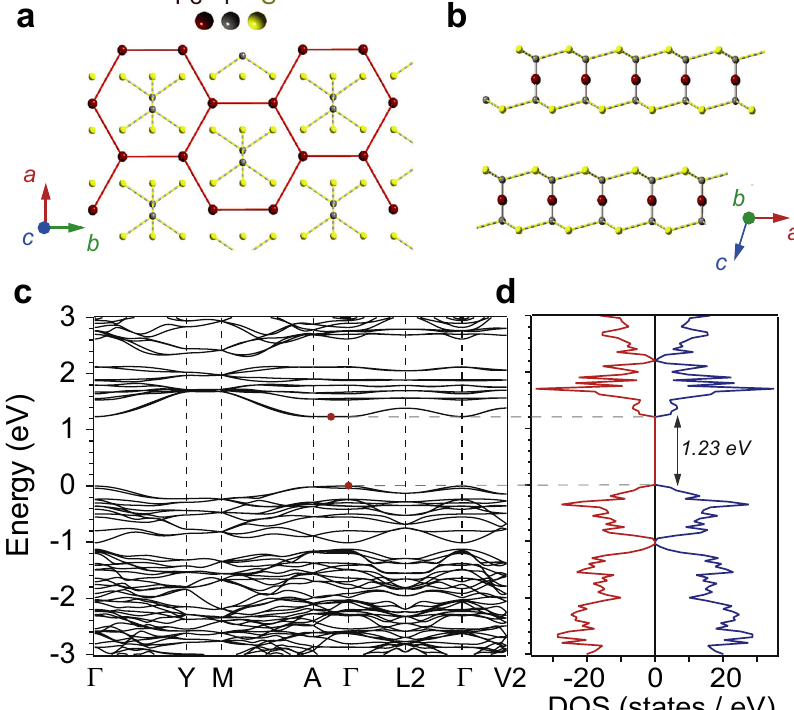
Fig. 3 Calculated band structure and DOS. a Top view and b side view of the crystal structure of FePS 3 . Fe 2 + ions form a honeycomb lattice, enclosed by the (P 2 S 6 ) 4 − bipyramids. The stacking of the layers of the monoclinic crystal structure is shown. Calculated GGA + D2 + U c band structure and d density of states: spin up (blue) and spin-down (red). The maximum and minimum of the valence and conduction bands respectively are marked with red dots de fi ning the indirect energy data in a Tauc plot representation. Assuming that our device photocurrent arises from an indirect bandgap transition 11,23 , the Tauc plot constructed with the dataset presented in Fig. 2c results in the blue color markers of Fig. 2d. The point where a linear fi t to the experimental data cuts the zero responsivity yields an estimate of E g = 1.23 eV. Photocurrent measurements using a Xenon white-light source integrated with a monochromator (Bentham) provide an improved energy resolution within the range of interest. The results, illustrated in the Tauc plot of Fig. 2d and represented by gray color markers, con fi rm the optical bandgap value previously obtained with the bench of LEDs. In addition to our experimental data, bulk FePS 3 absorbance measurements have been extracted from a work published by Brec et al. 11 and integrated in our Tauc plot as red color markers. It can be observed that our experimental results, based on the photocurrent response of the device, are in good agreement with the optical absorption measurements provided by Brec et al., except for energies below ∼ 1.32 eV, where d – d transitions dominate the absorption spectrum. These d – d transitions are they are not expected to contribute to the photocurrent generation.